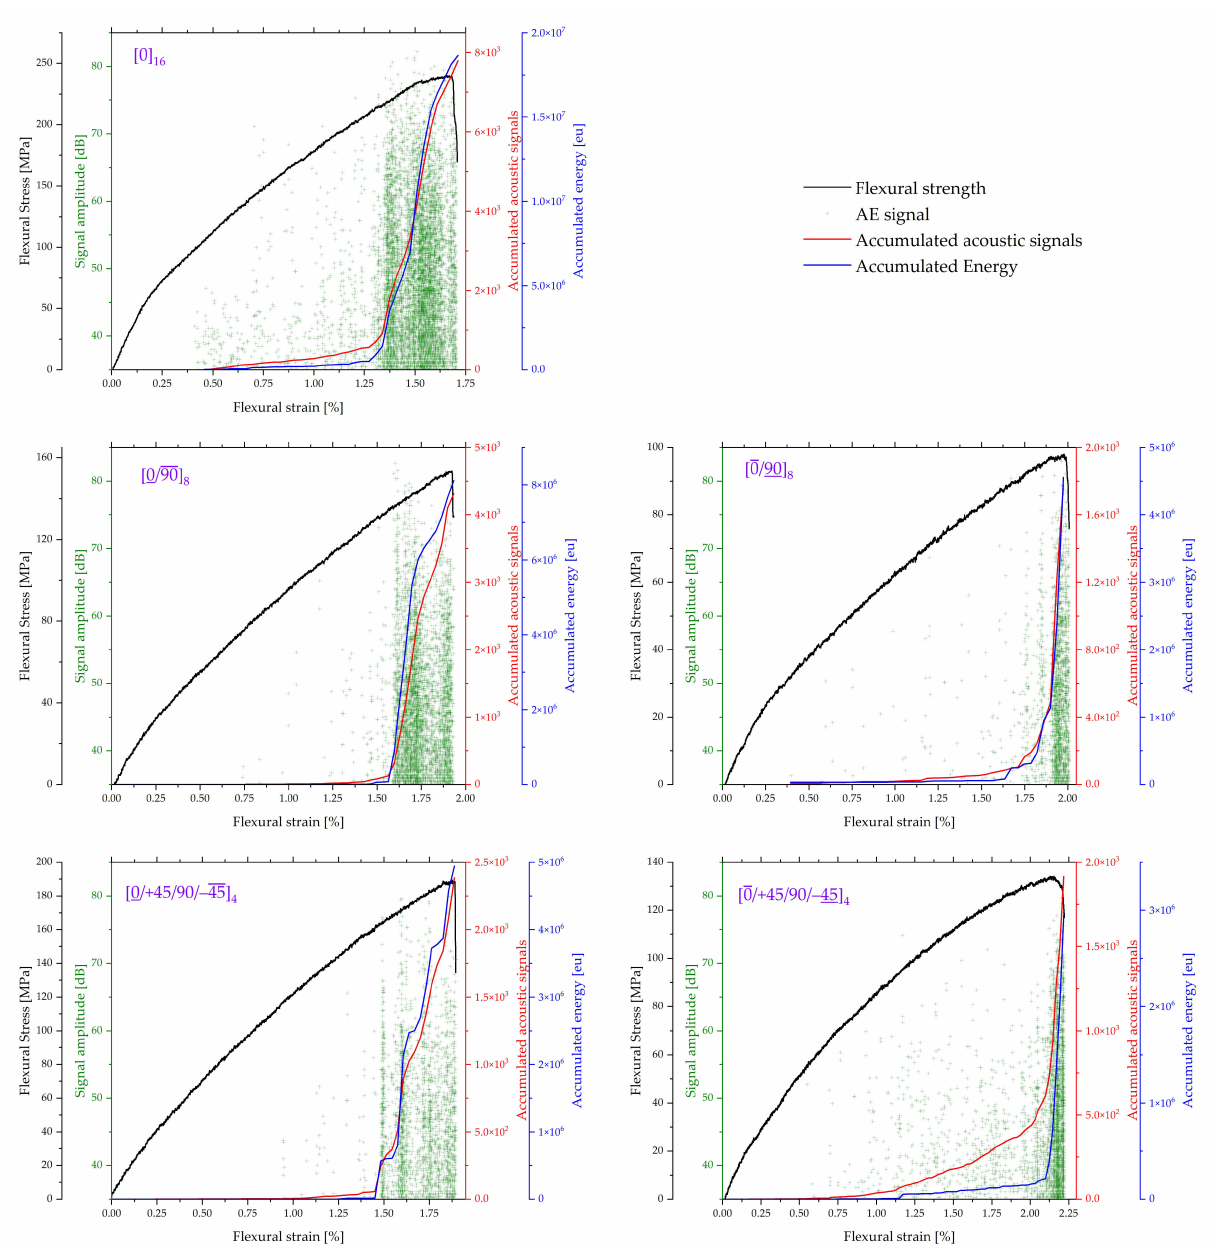
Figure 5. Relationship between the applied force, the detected acoustic emission signal amplitude, and the accumulated acoustic